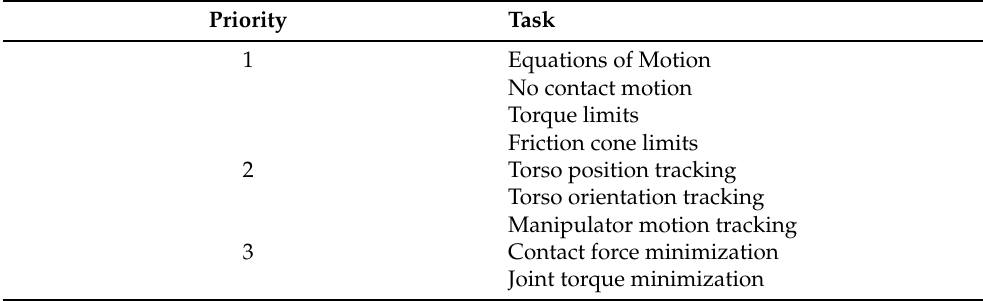
Table 1. The describe of task priority in